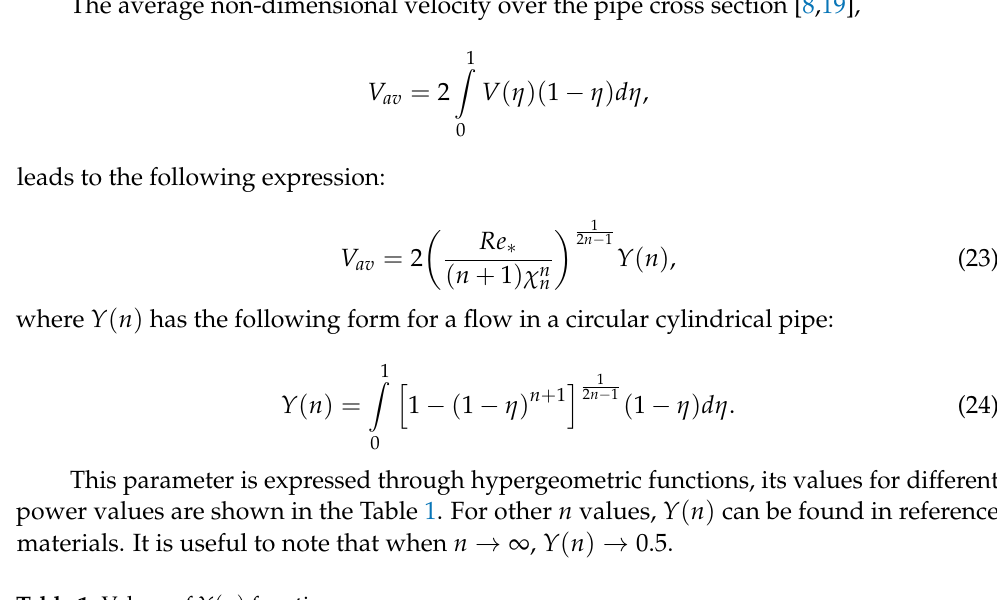
Table 1. Values of Y ( n )